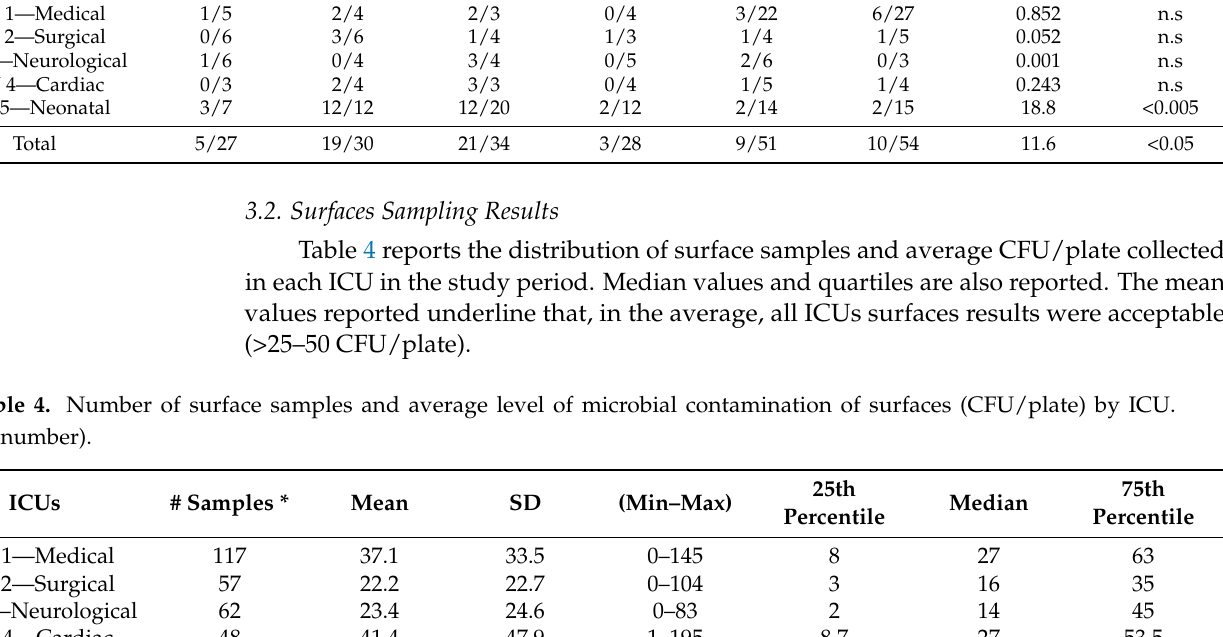
Table 4. Number of surface samples and average level of microbial contamination of surfaces (CFU/plate) by ICU. ICUs